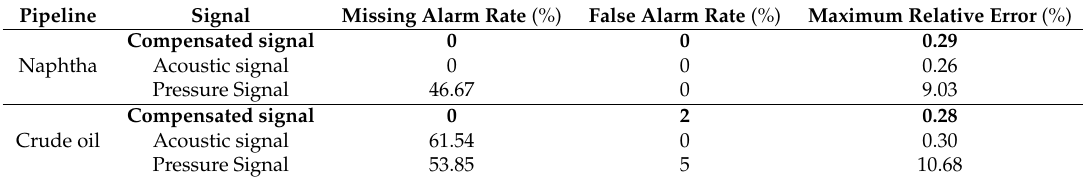
Table 3. Leak detection and location results of the compensated signals, acoustic signals, and pressure signals.